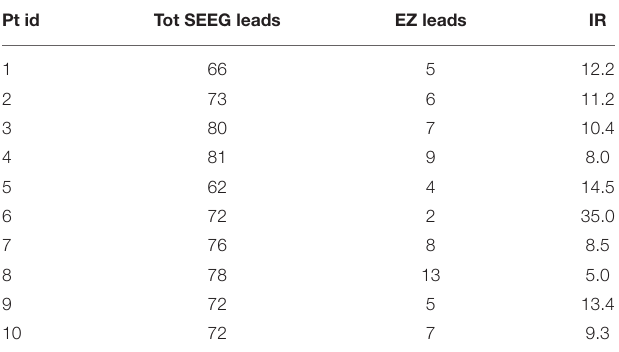
TABLE 2 | Number of analyzed SEEG leads (Total SEEG leads), number of leads belonging to the EZ (EZ leads), and Imbalanced ratio (IR) per patient.